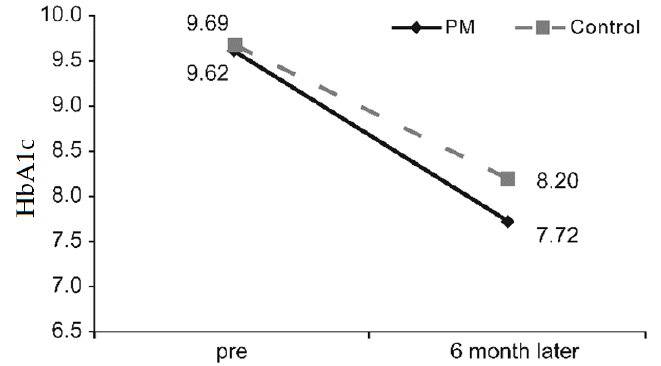
Figure 4. Differences in HbA1c according to education groups. PM, pattern management. Figure 4. Di ff erences in HbA1c according to education groups. PM, pattern